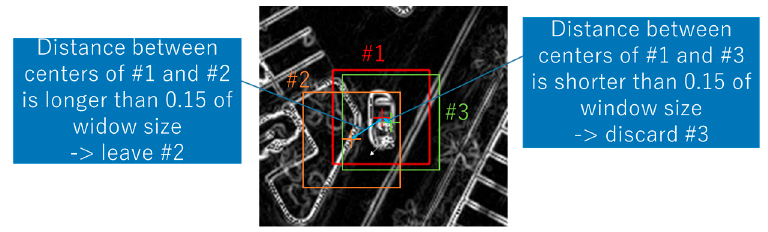
Figure 5. How to discard unnecessary windows.